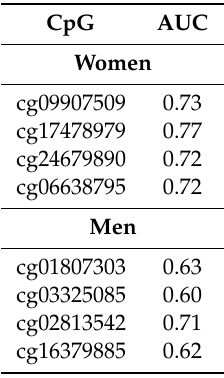
Figure 4. Receiver operating characteristic (ROC) curves. ( A ) Top four significant di ff erentially methylated CpGs for females adjusted by age; ( B ) Top four significant di ff erentially methylated CpGs for males adjusted by age. Table 2. Validation of ROC curves in an independent sample ( n = 161) for the top four significant di ff erentially methylated CpGs for each sex adjusted by